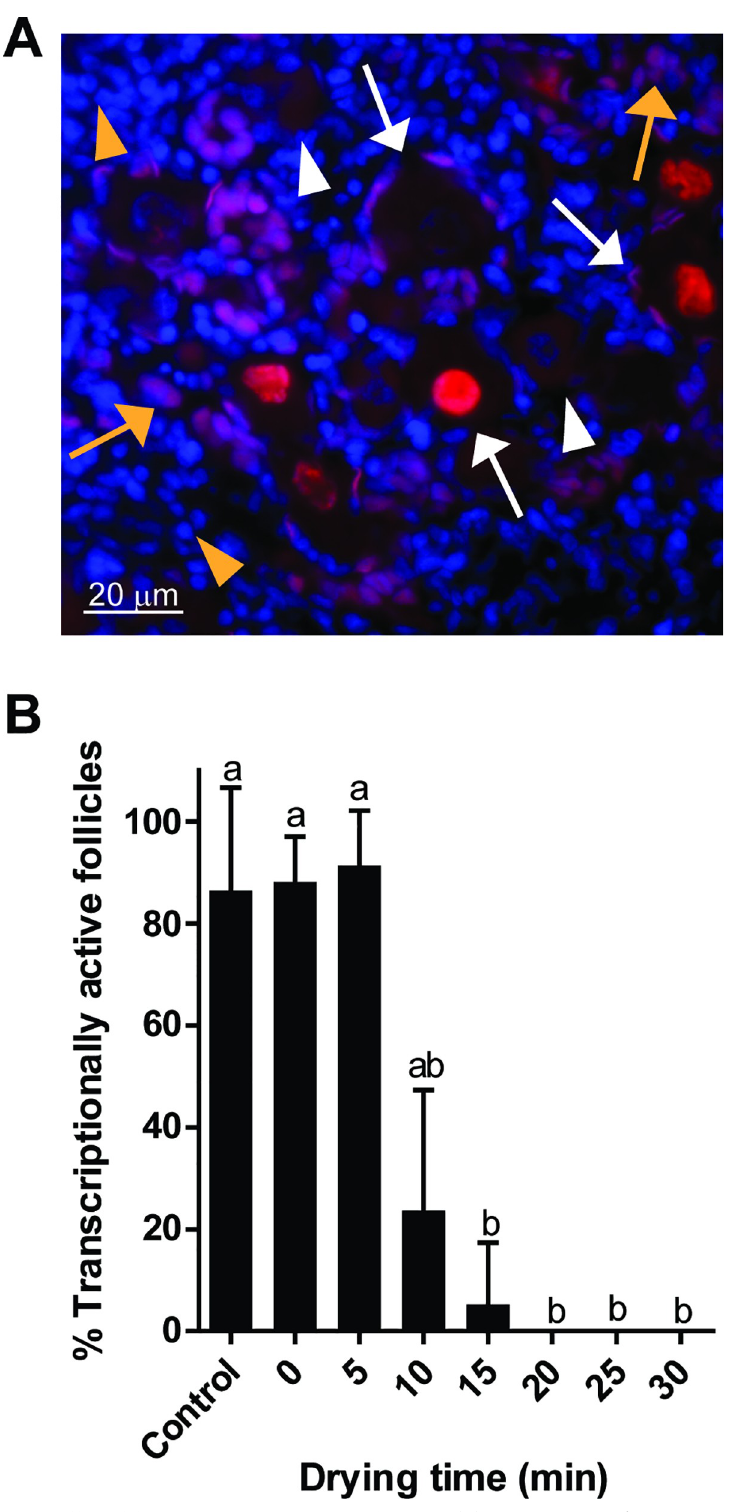
Fig 7. Effect of drying time on transcriptional activity. (A) Representation of transcriptional activities after EU fluorescent labelling. White arrows: transcriptionally active follicles, white arrowheads: transcriptionally inactive follicles, yellow arrows: transcriptionally active somatic cells, and yellow arrowheads: transcriptionally inactive somatic